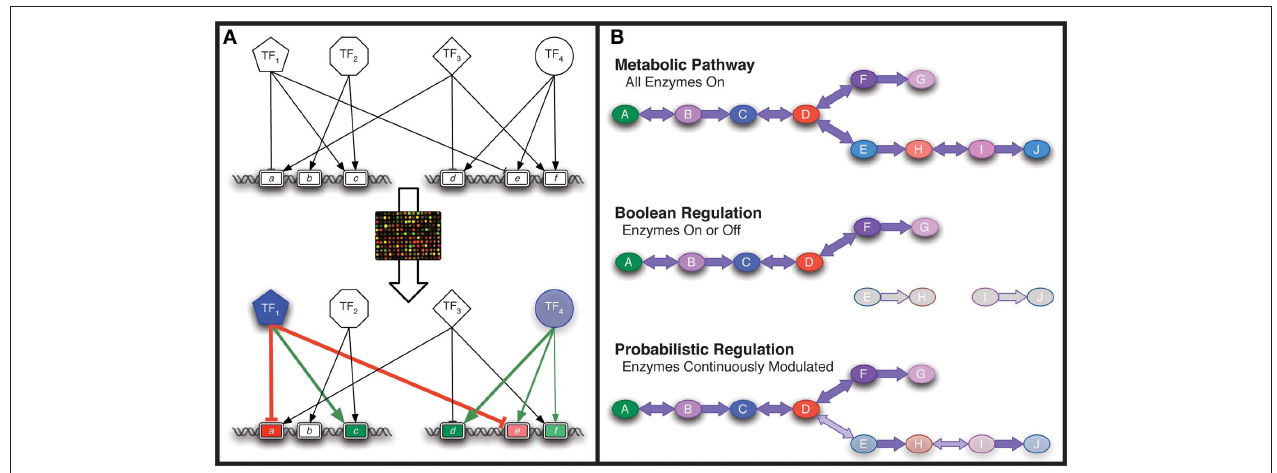
FiGuRe 3 | systems modeling approaches. (a) Network component analysis uses transcriptome data to deduce transcription factor (TF) activities given a TF/gene (g) connectivity network. (B) Genome-scale metabolic models are constructed with all enzymes. With Boolean regulatory constraints, enzymes are either expressed or not expressed. With probabilistic regulatory constraints, the enzyme expression levels are modulated based on expression level of